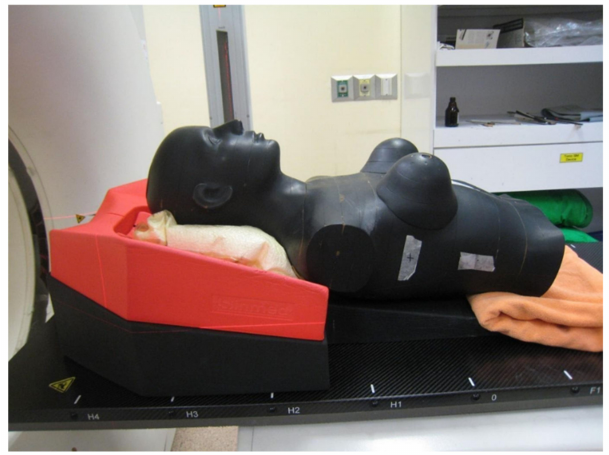
Figure 1. Female RANDO ® human phantom with tilted wedge immobilization devices and